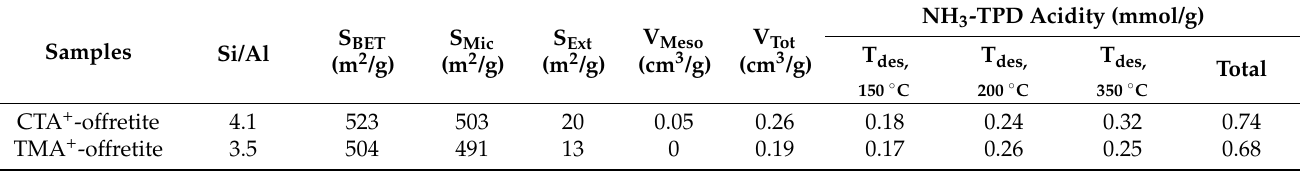
Table 1. Properties of offretite